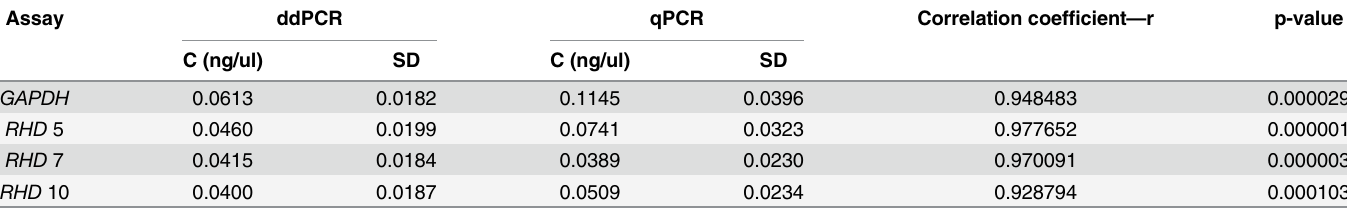
Table 1. Average concentrations and standard deviations of four analyzed DNA regions measured in plasma of 10 non-pregnant subjects. Assay